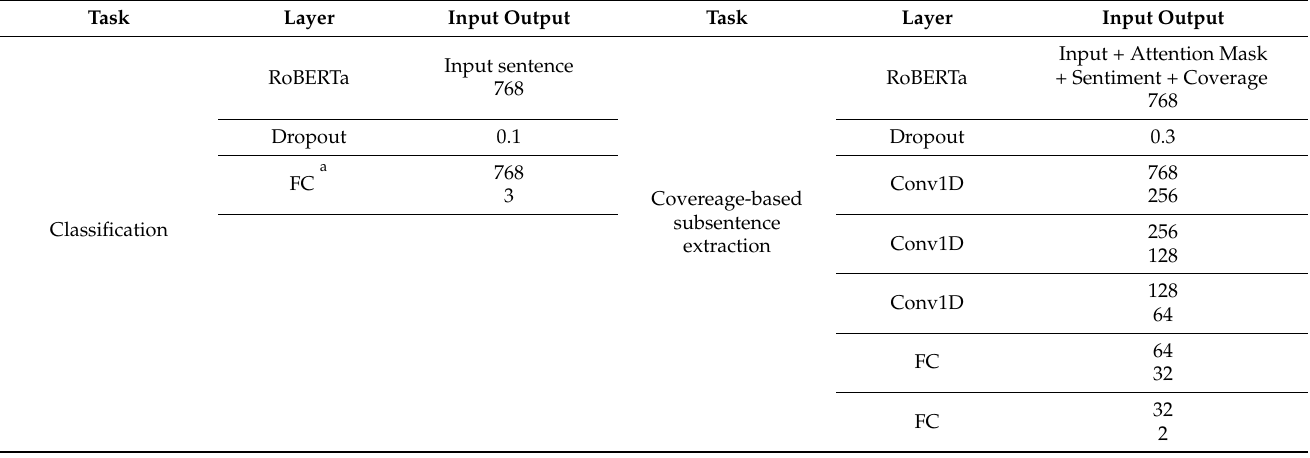
Table 6. Emotion classification and subsentence extraction network